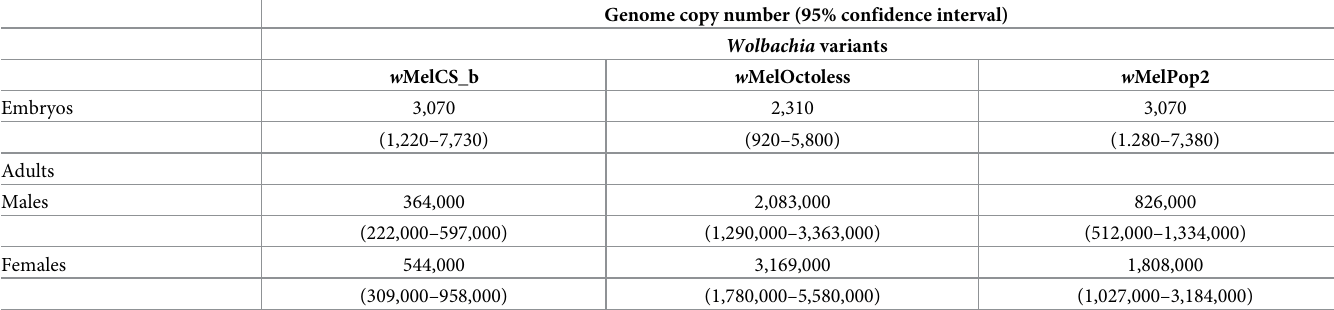
Table 2. Wolbachia genome copies in embryos and newly eclosed adult